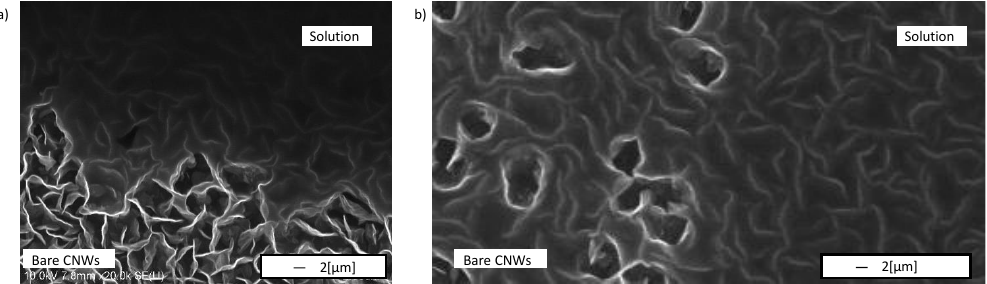
Figure 4. SEM images of the CNWs / Si substrate, after dropping the arginine-dissolved solution on the CNW surface, treated ( a ) without or ( b ) with atmospheric pressure plasma.